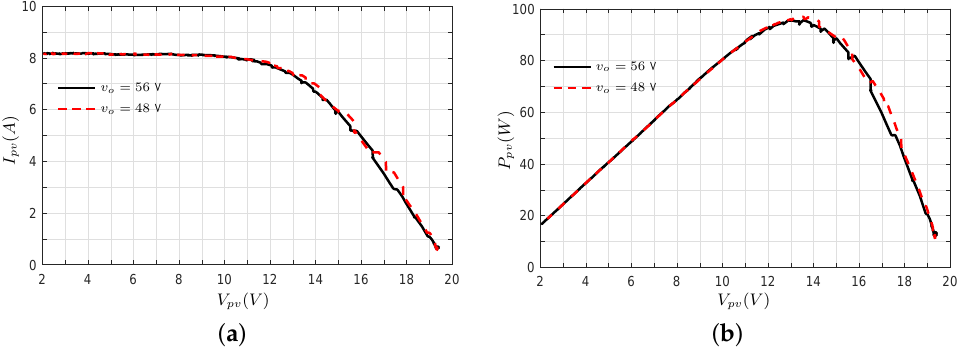
Figure 18. Experimental results in the converter’s input port. ( a ) I–V curve. ( b ) P–V